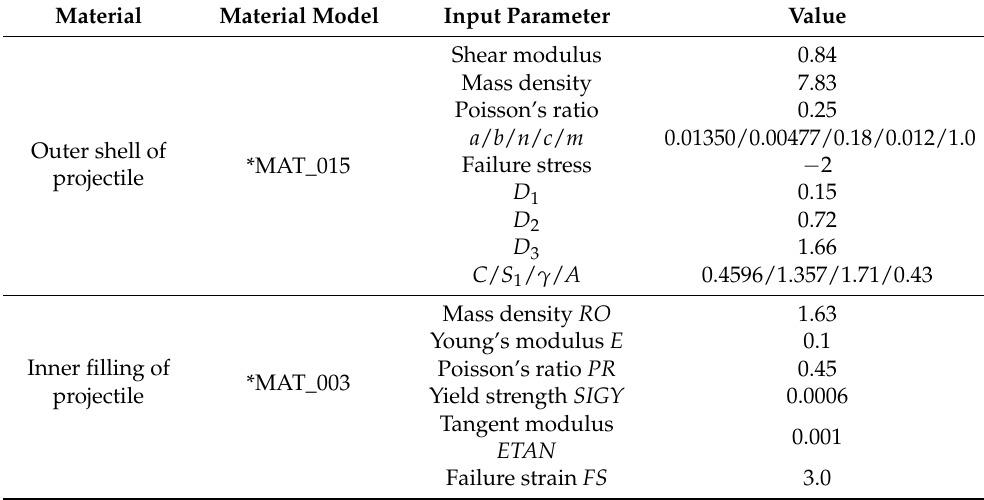
Table 5. Parameters of material models for projectile [3] (units: cm-g-µs).